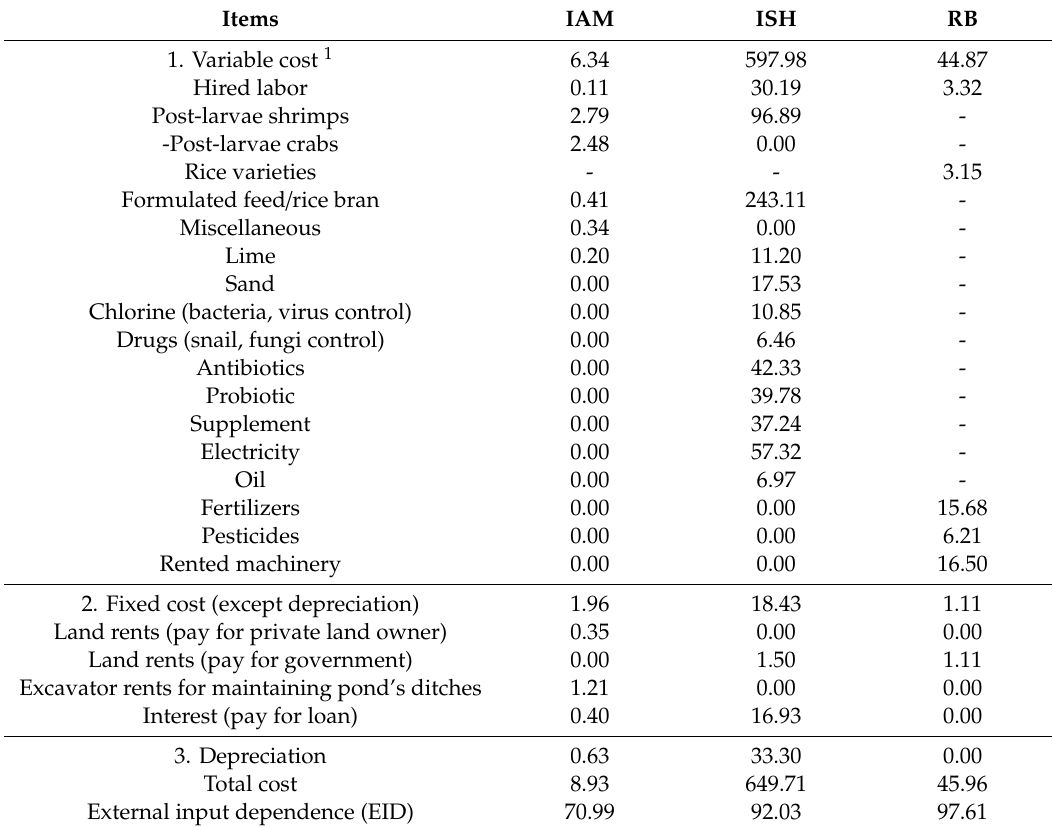
Table 3. Costs of production. Unit: mil. / ha /